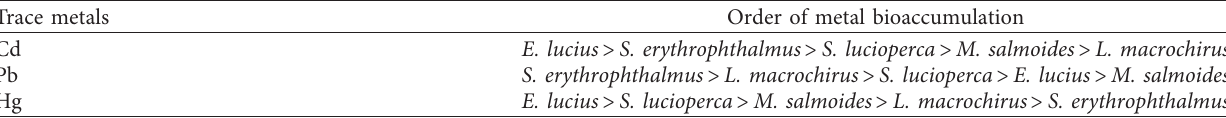
Table 5: The order of the bioaccumulation of trace metals in the muscles of the studied fish species.